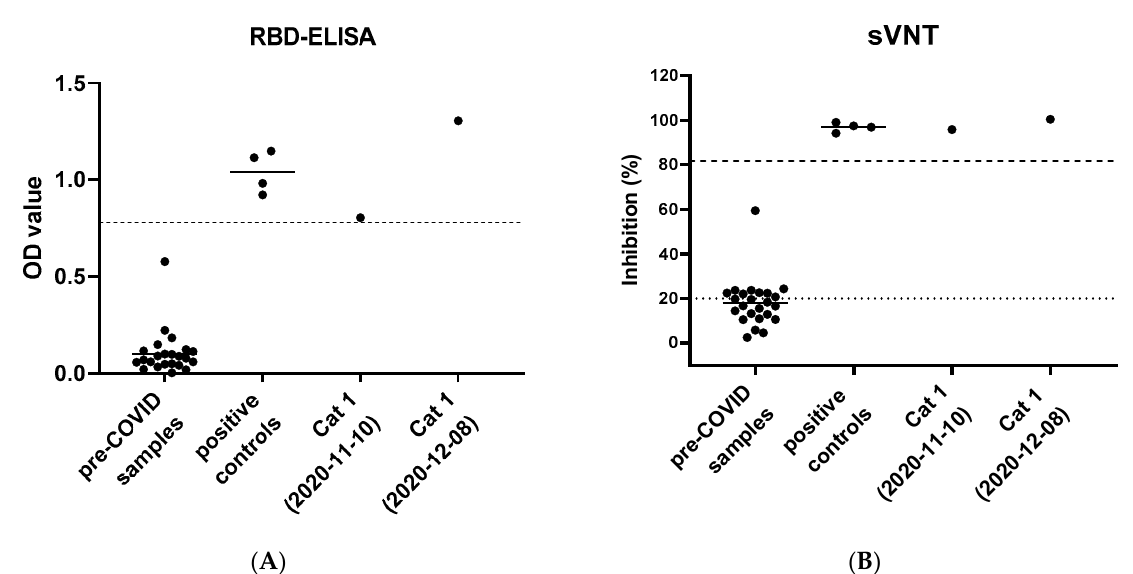
Figure 4. Serological results of two consecutive serum samples from Cat 1 and control samples. ( A ) receptor binding domain enzyme-linked immunosorbent assay (RBD-ELISA) results from Cat 1 compared to a precoronavirus disease 2019 (COVID-19) control group ( n = 24) and a positive control group ( n = 4). Serum from Cat 1 from 10 November 2020 and 8 December 2020 yielded OD values of 0.81 and 1.31, respectively. Pre-COVID-19 control group sera (collected from Swiss cats before 5 January 2020) showed a mean OD value of 0.10. Positive control group sera showed a mean OD of 1.04. The dashed line indicates six-fold standard deviations of the mean OD of the pre-COVID-19 samples. ( B ) Surrogate virus neutralization test (sVNT) results from Cat 1 compared to a pre-COVID-19 control group ( n = 24) and a positive control group ( n = 4). Cat 1 showed an inhibition of 95.9% and 100.4% on 10 November and 8 December 2020, respectively. The mean inhibition of pre-COVID-19 sera was calculated at 18%. Positive control sera resulted in a mean inhibition of 96.9%. The dotted line indicates the positive cutoff determined by the manufacturer at an inhibition of ≥ 20% The dashed line indicates six-fold standard deviations of the mean inhibition of the pre-COVID-19 samples at 81.8%.